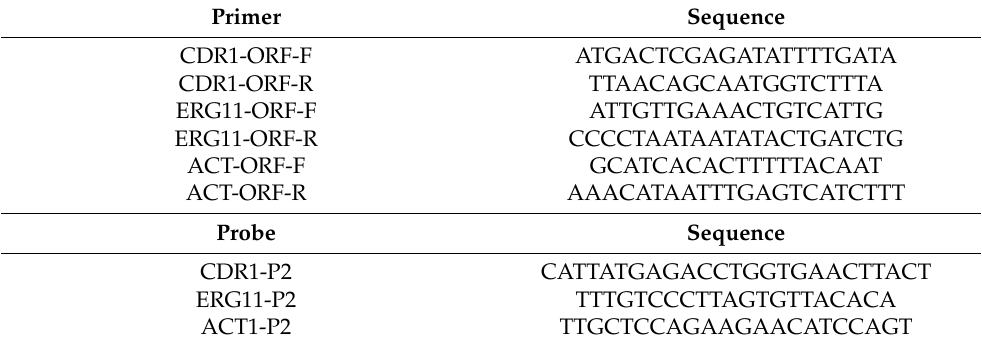
Table 3. Sequences of TaqMan primers and probes used in